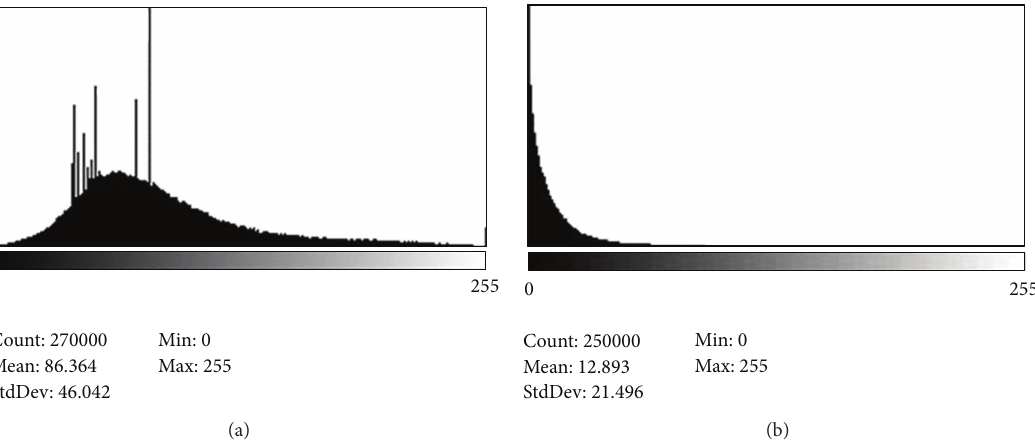
Figure 9: The two PET image data sets analyzed in the present study represent very different intensity distributions (full volumetric image sets). The histogram for Heart 1 (a) has a higher mean intensity value and standard deviation than those of Heart 2 (b) image data set.